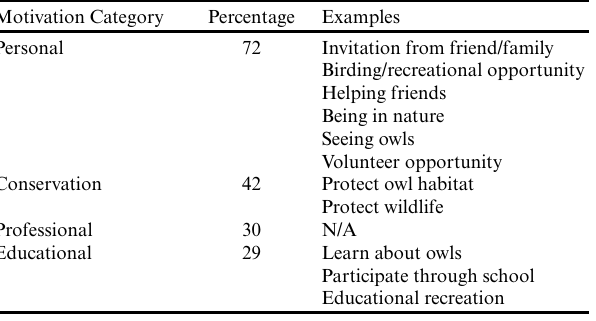
Table 3 . Motivations identified by participants of the Manitoba Nocturnal Owl Survey in a questionnaire on participation behavior and scientific attitude distributed during November 2015–January 2016 (n = 69). Some respondents identified multiple motivations, and respondents were given the option to elaborate on their motivations.